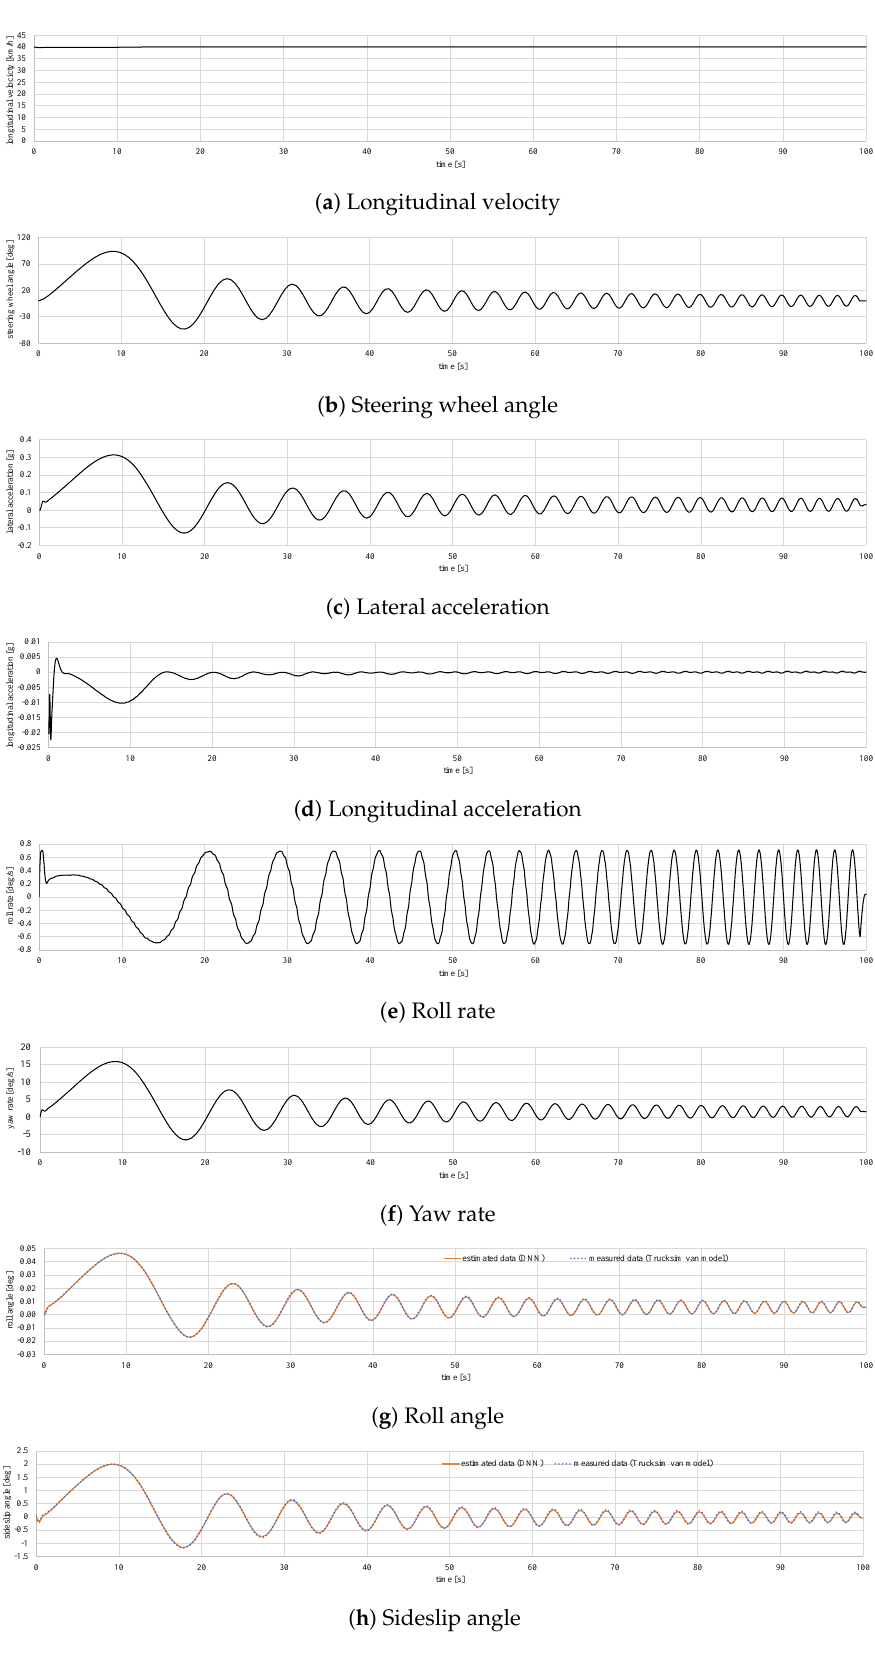
Figure 10. Simulation results for the validation